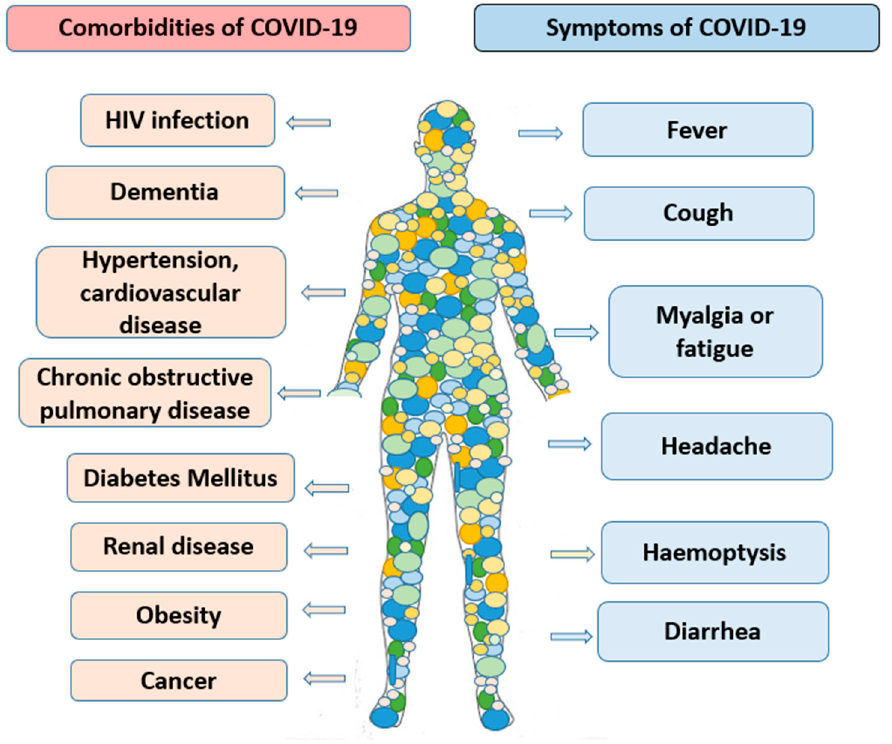
Figure 1. The main comorbidities and symptoms of COVID-19